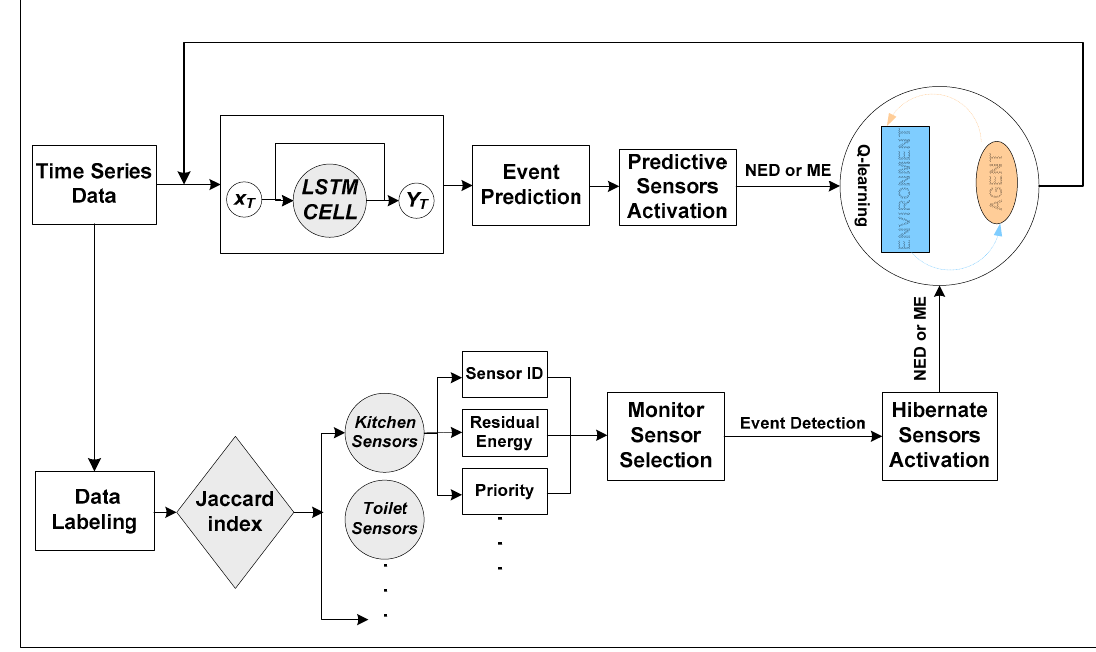
Figure 1. The working of the proposed EEA-SDC (Energy and Event Aware-Sensor Duty Cycling) scheme. Figure1.